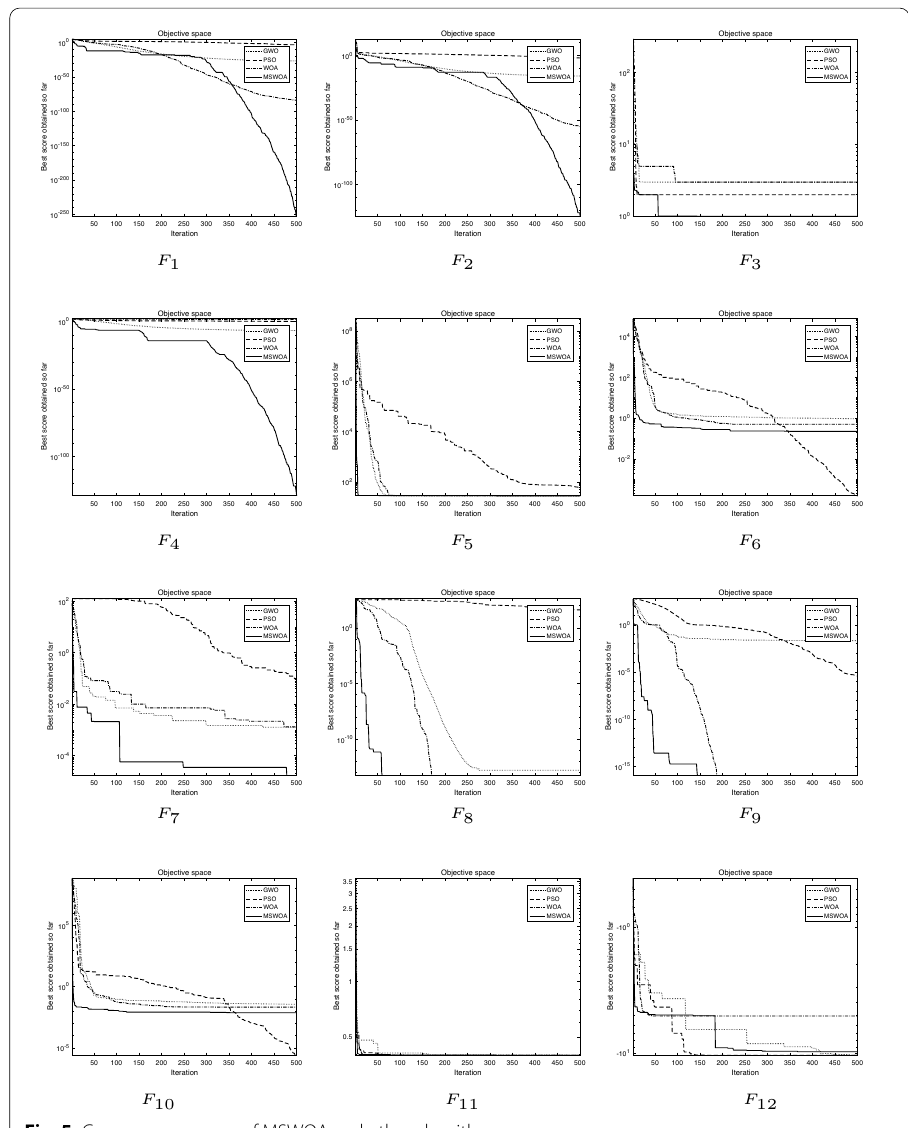
Fig. 5 Convergence curve of MSWOA and other